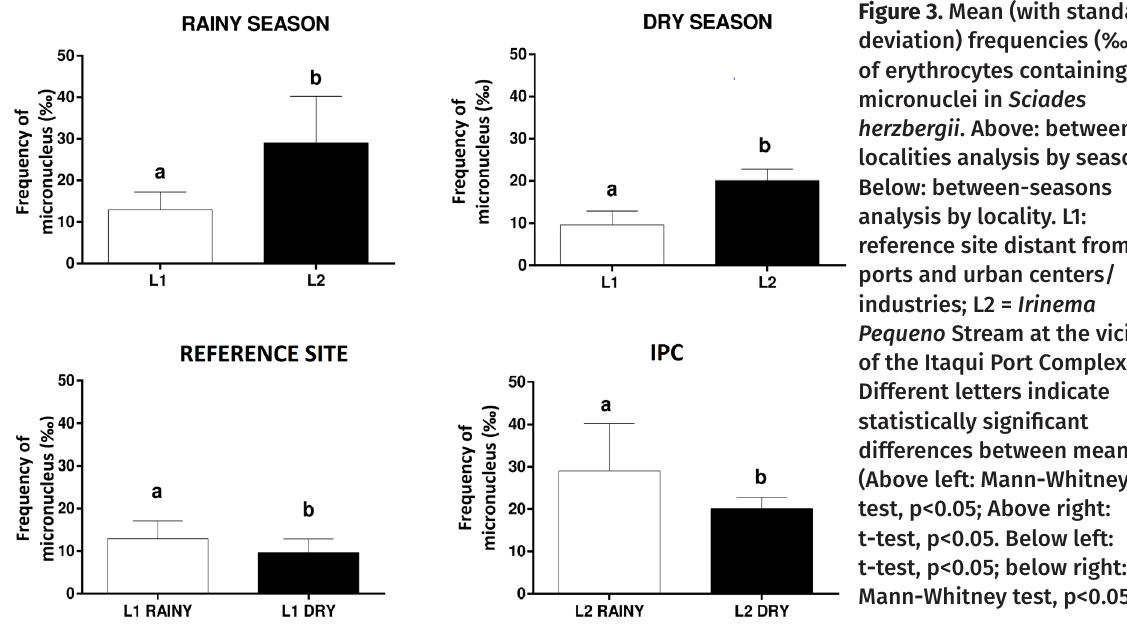
Figure 3. Mean (with standard deviation) frequencies (‰) of erythrocytes containing micronuclei in